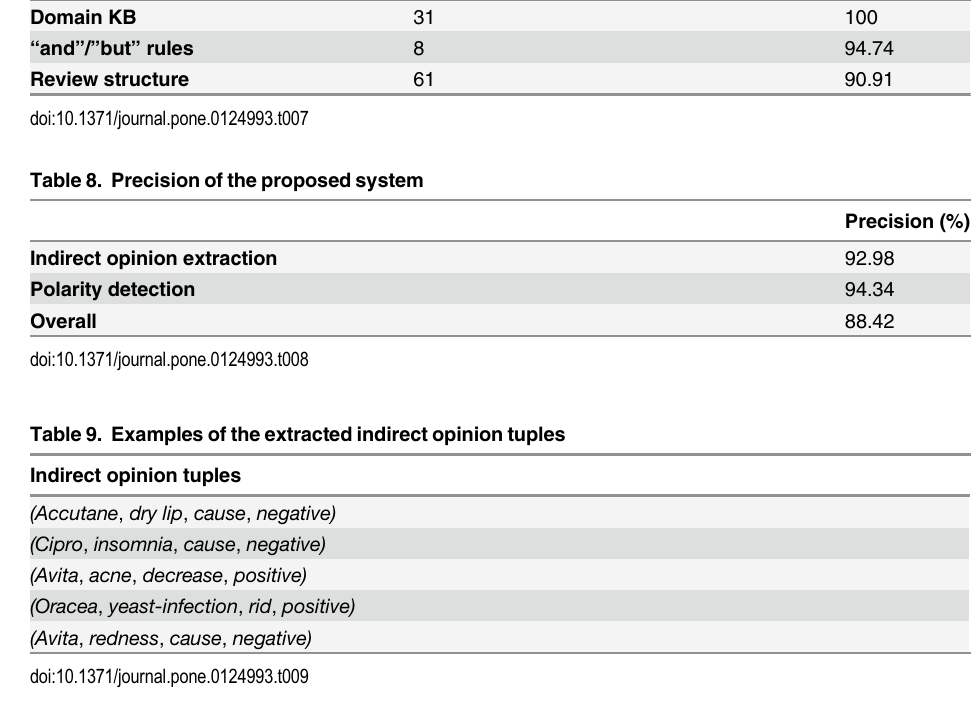
Table 7. The accuracy of the polarity detection sub-modules Polarity detection sub-module Tagged sentences and phrases (%)